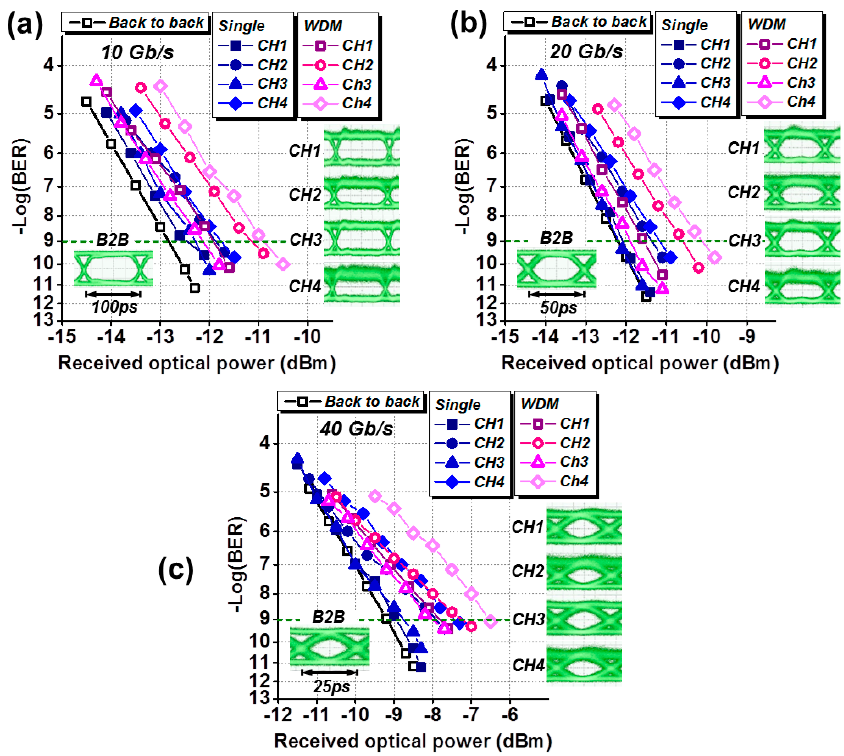
Figure 11. BER curves for single channel and WDM channel input at ( a ) 10 Gb/s; ( b ) 20 Gb/s; and ( c ) 40 Gb/s.